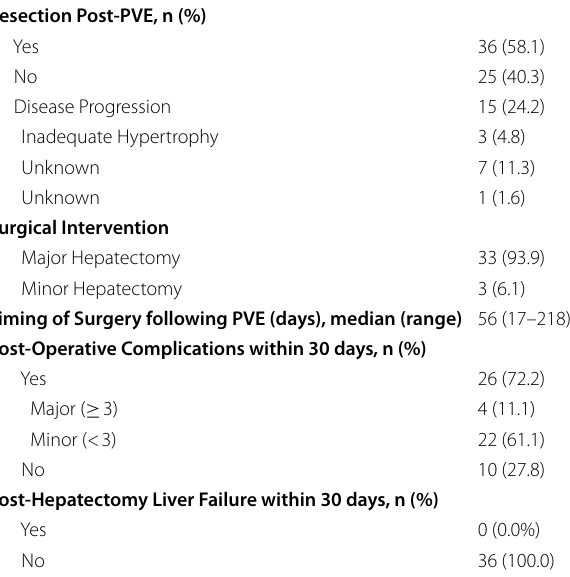
Table 3 Surgical outcomes Resection Post-PVE, n